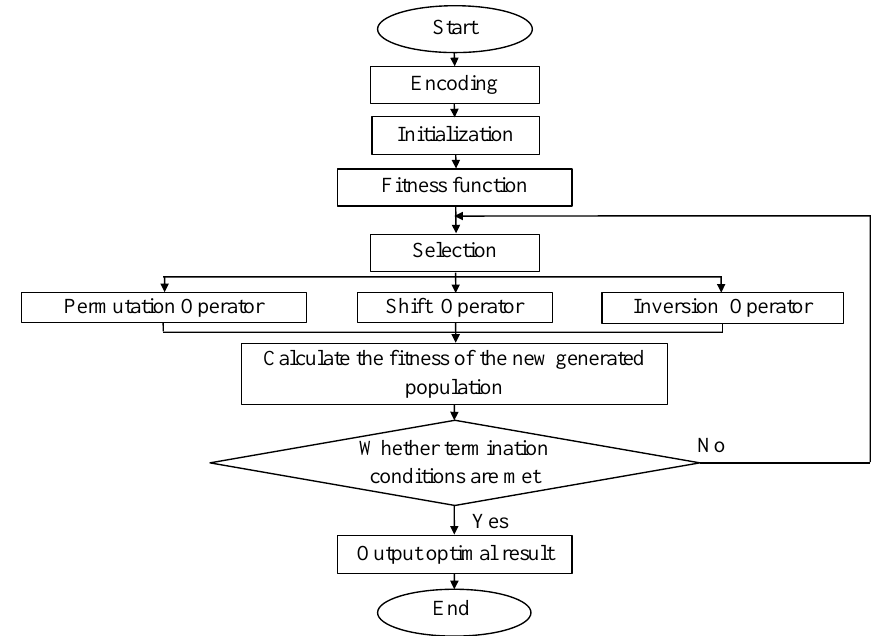
Figure 1. The flow chart of the parthenogenetic algorithm (PGA).